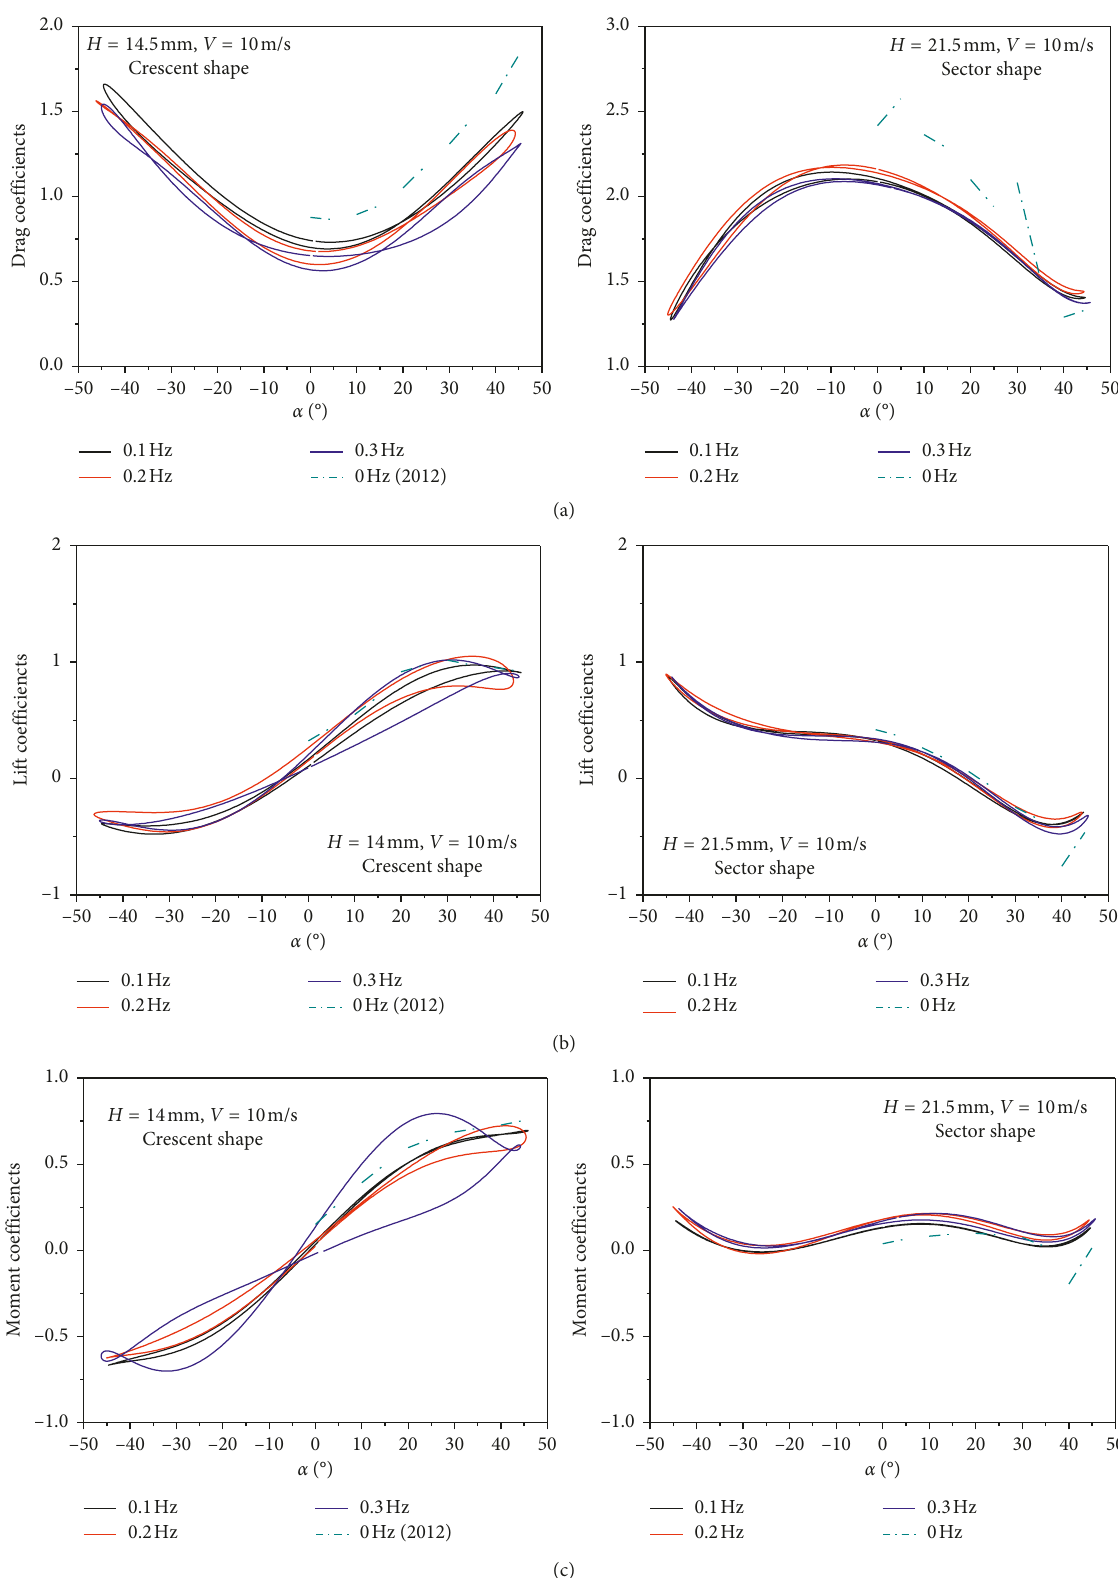
Figure 6: The unsteady aerodynamic coefficients of crescent-shape and sector-shape iced subconductor 1 under different frequencies: (a) drag coefficients; (b) lift coefficients; (c) moment